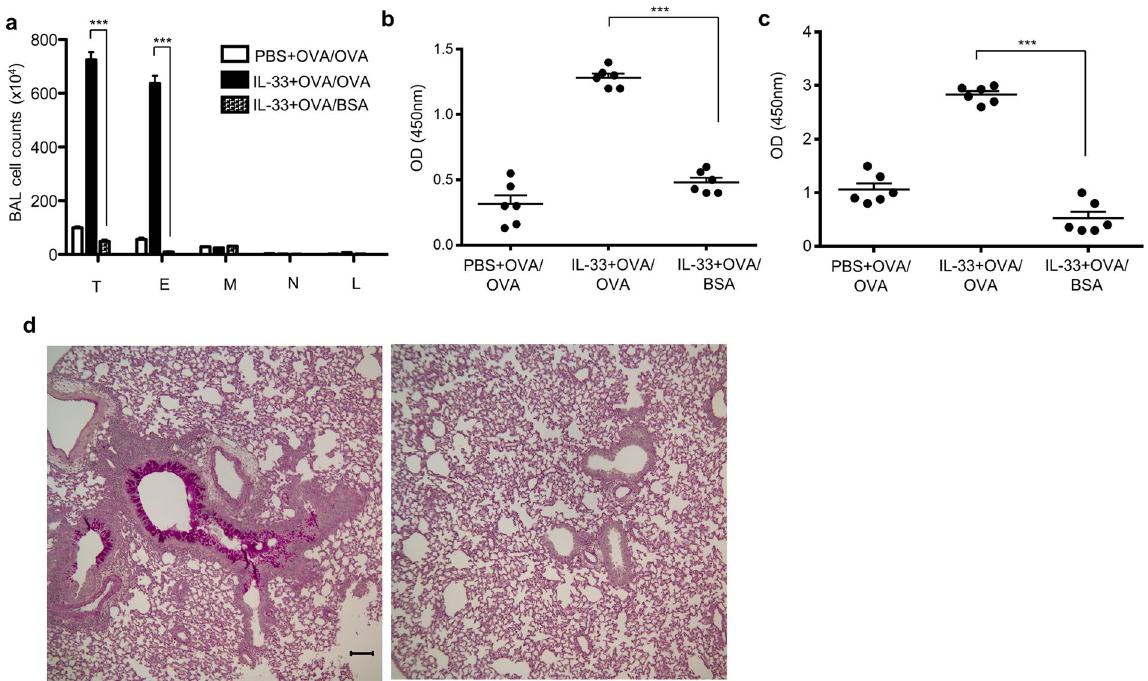
Figure 4. Airway inflammation is antigen-specific. To test the antigen specificity of atopic model, low endotoxin bovine serum albumin (BSA) was used to challenge the mice. ( a ) Cell counts in the BAL fluid. ( b ) OVA-specific IgE in BAL fluid. ( c ) OVA-specific IgE in serum. ( d ) Representative lung tissue cross-sections stained with PAS. Left, IL-33 + OVA/OVA; right, IL-33 + OVA/BSA. Bar, 100 µ m. T, total cells; E, eosinophils; M, macrophages; N, Neutrophils; L, lymphocytes. Data were pooled from two independent experiments (n = 6). Error bars indicate the mean ± SD. *** p ≤